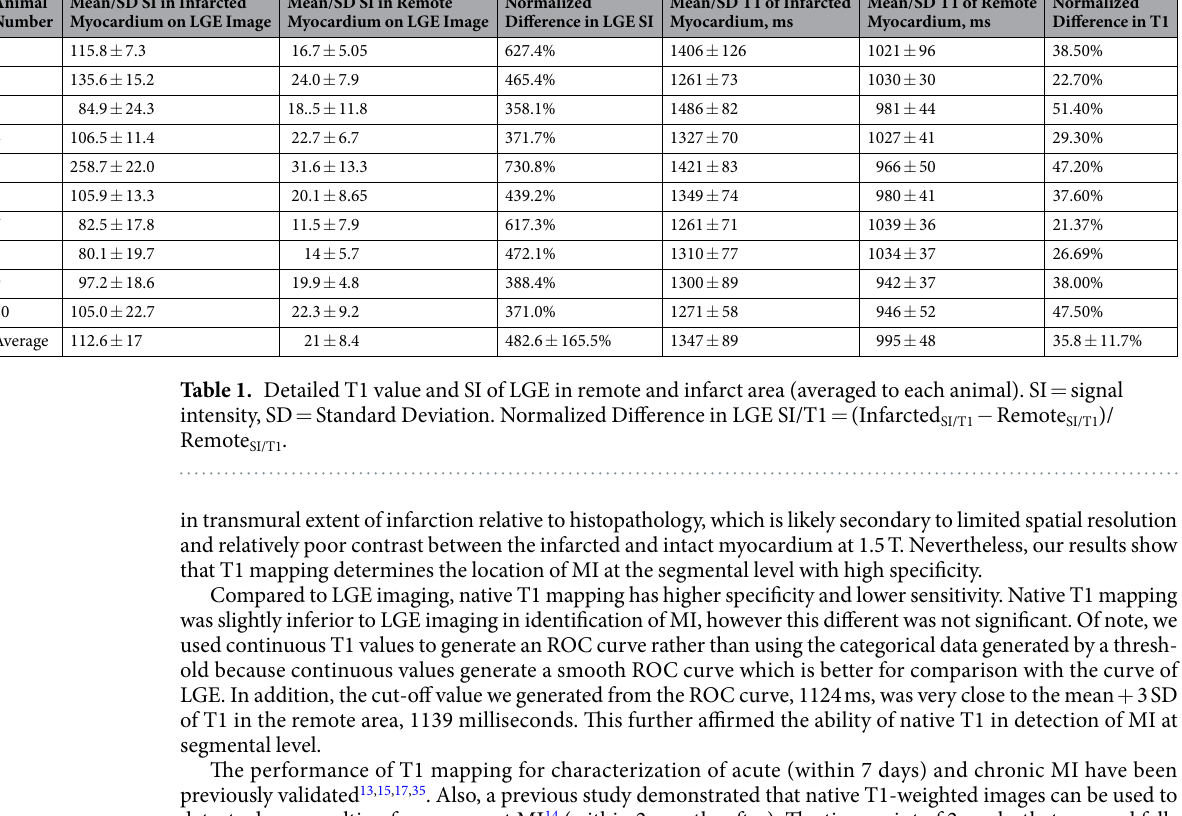
Animal Mean/SD SI in Infarcted Number Myocardium on LGE Image